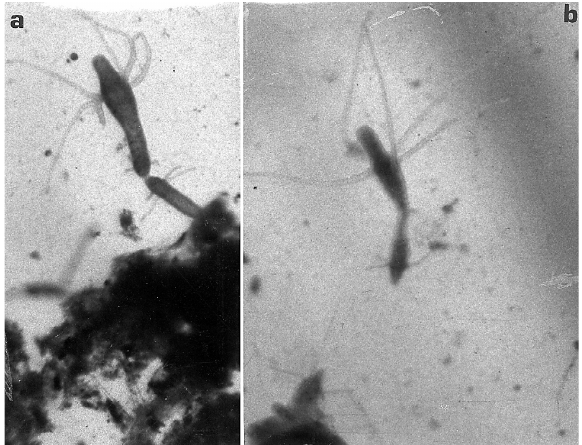
F IG . 3. – Photomicrographs of a chain of three elements, showing the whorls of tentacles (a) and of a double polyp floating in